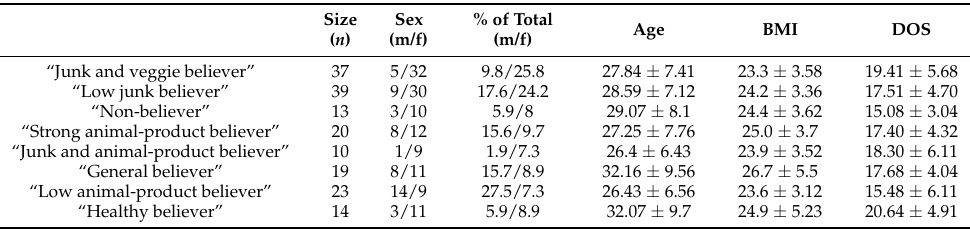
Table 5. Mean scores of indicators used in LPA, group name and size, as well as age, BMI, sex distri- bution and DOS of the 8 profiles showing 8 different nutritional beliefs about stress-relieving foods. Size ( n